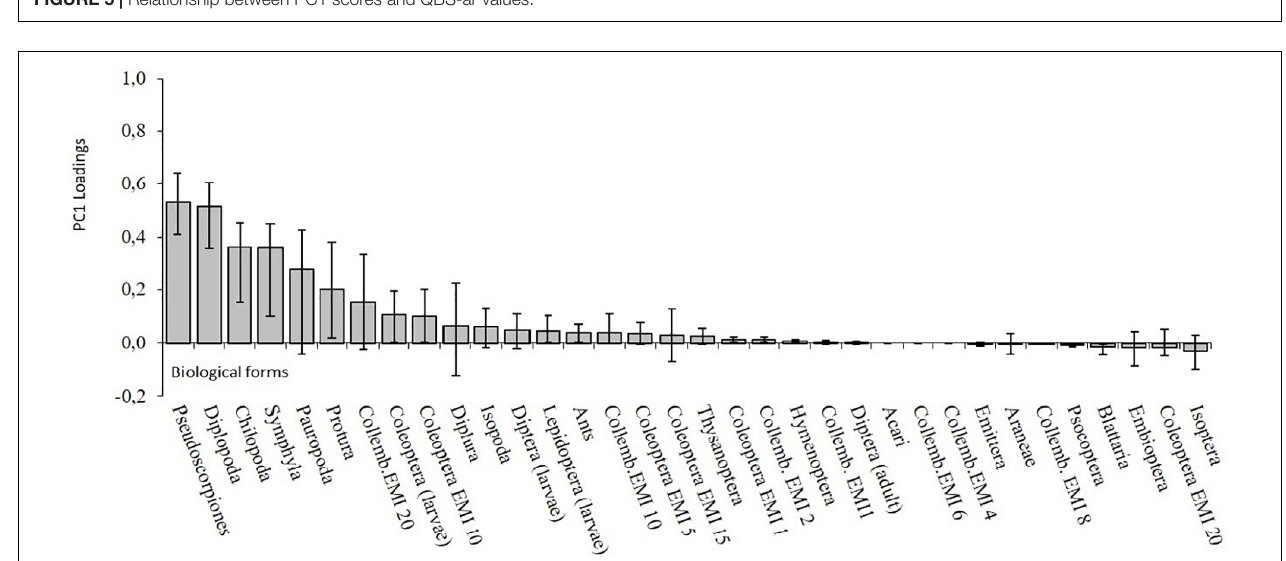
FIGURE 5 | Relationship between PC1 scores and QBS-ar values.